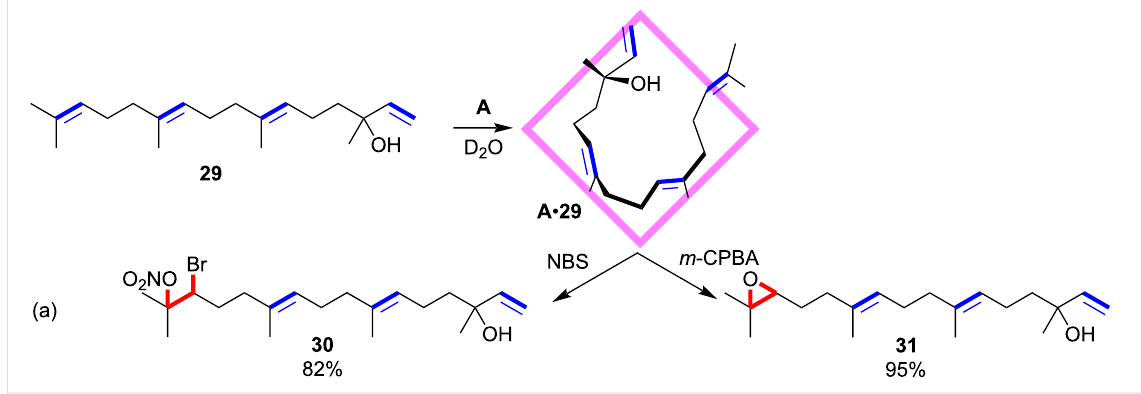
Figure 9: Site-selective oxidations of linear diterpenoids with the help of cage host A .